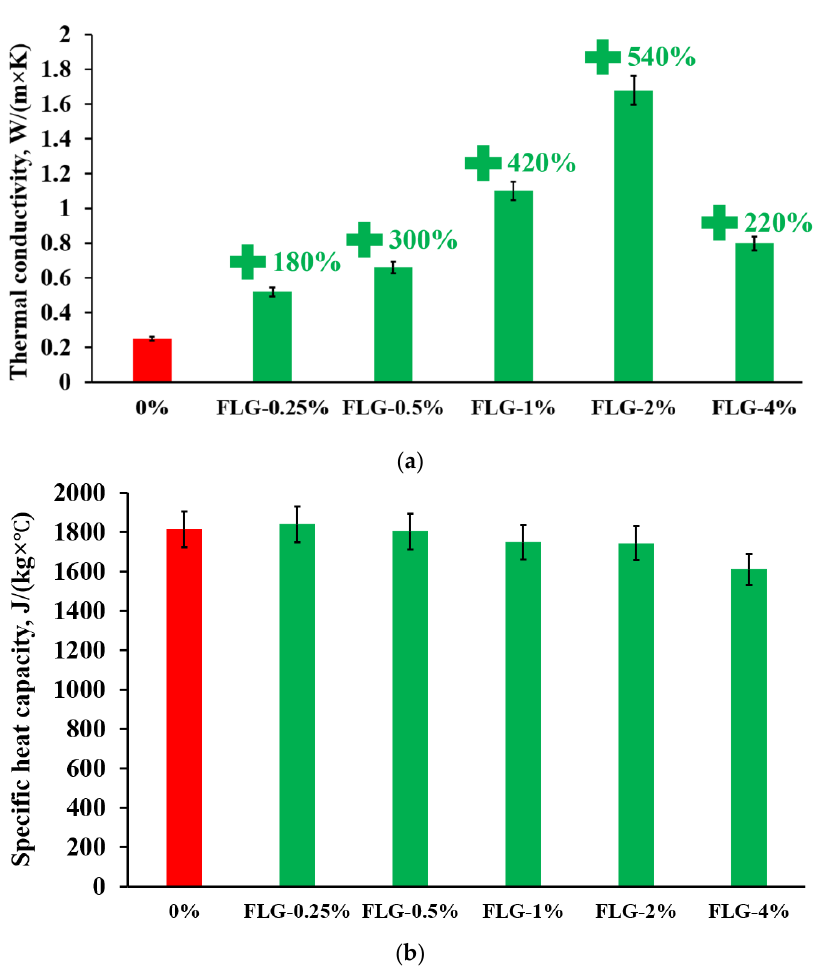
Figure 9. Dependence of thermal conductivity ( a ) and specific heat capacity ( b ) of synthesized samples on FLG concentration at 25 °C.